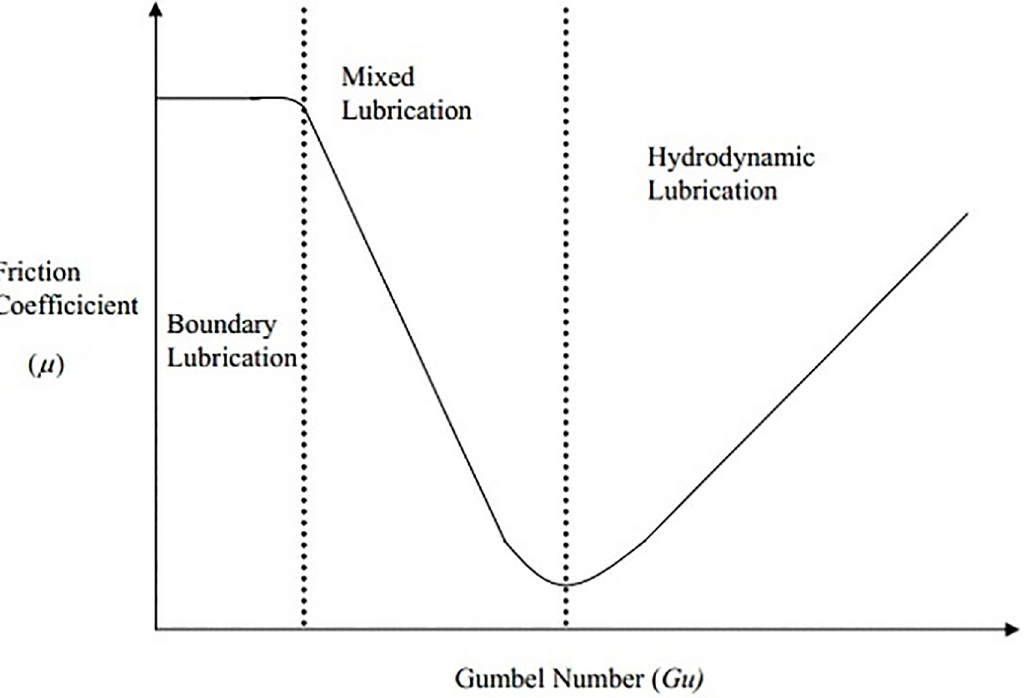
Fig 6. Stribeck curve. Dynamic viscosity ŋ , shaft rotation rate ω , and mean pressure P and the friction coefficient μ for a typical rotating bearing. Lubrication modes of a system are related to asperity-asperity interaction and fluid separation of two surfaces as suggested by the inset cartoons.